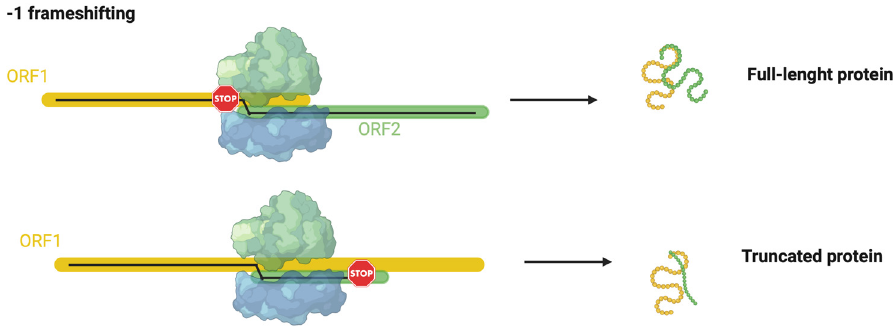
Figure 4. − 1 frameshifting mechanisms summarized. ORF1 is underlined in yellow. This figure was created with BioRender.com (accessed on 7 December 2022).